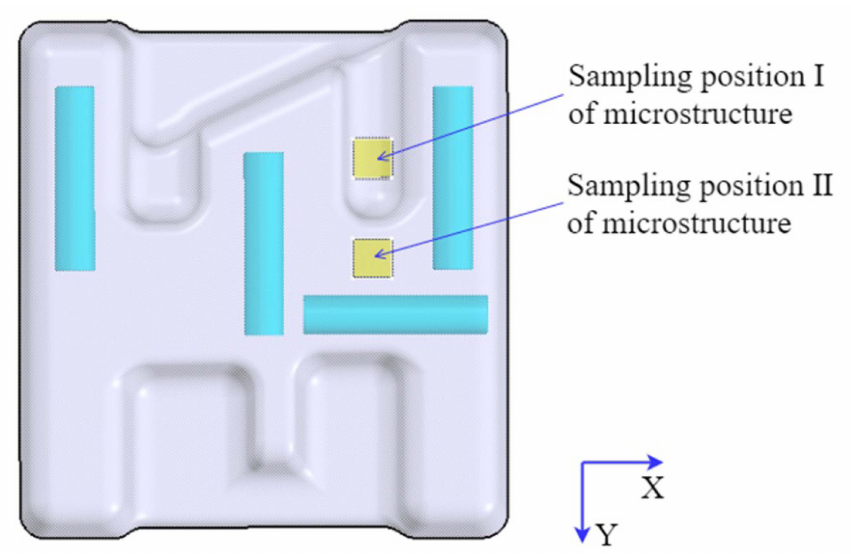
Figure 15. Schematic diagram of the sampling position of